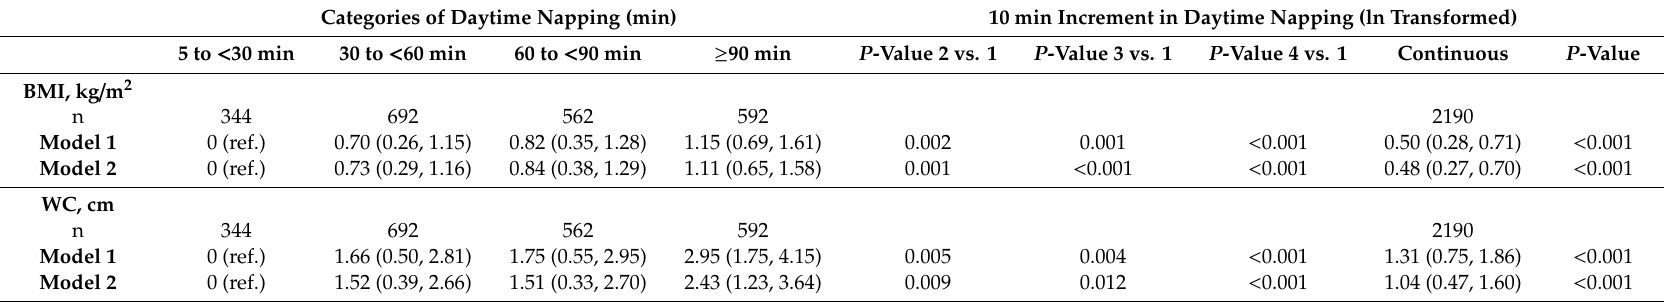
Table 3. Multivariable-adjusted β -coe ffi cients (95% CI) according to categories of daytime napping and per increment of 10 min in daytime napping (ln-transformed) in relation to body mass index and waist